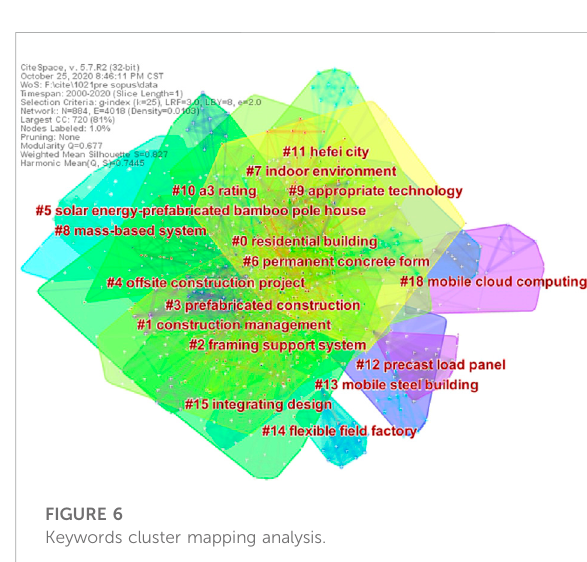
FIGURE 6 Keywords cluster mapping